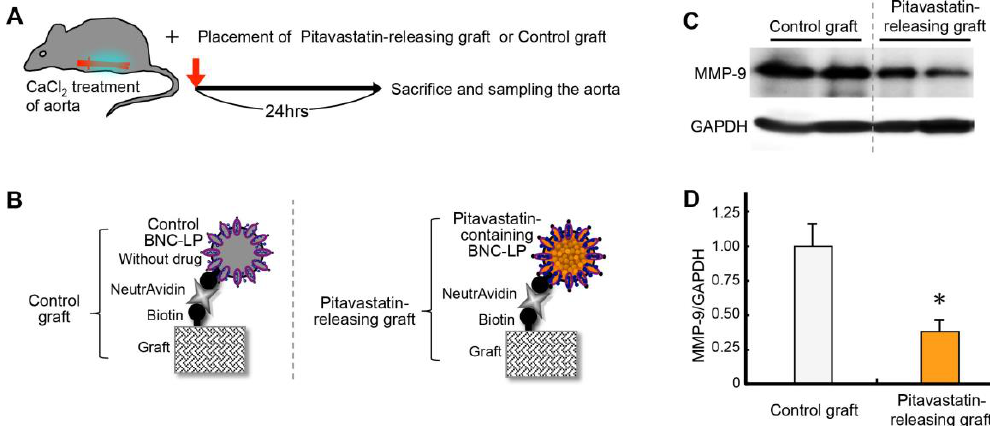
Figure 8. Effect of releasing drug from the graft charged with BNC-LP complexes on mouse aortic tissues. ( A ) Schematic diagram of the experimental design: CaCl 2 induces inflammation in the aorta (red); the pitavastatin-releasing graft or the control graft is placed next to the aorta. ( B ) Schematic diagram of the experiment: the pitavastatin-releasing graft is compared to the control graft. ( C ) Representative images of western blots for estimating the expression of matrix metalloproteinase-9 (MMP-9) relative to glyceraldehyde 3-phosphate dehydrogenase (GAPDH) expression (internal loading control). ( D ) Quantification of MMP-9 expression in mouse aortic tissues. Data are the means ± standard deviations of 5 independent observations. * p < 0.05 compared to the control.